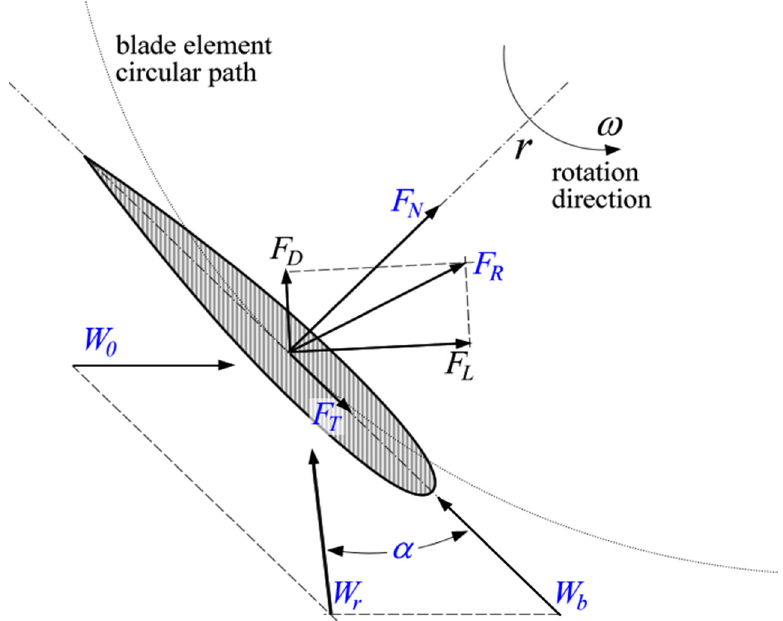
Figure 2. Velocity and force components for a Darrieus-type VAWT